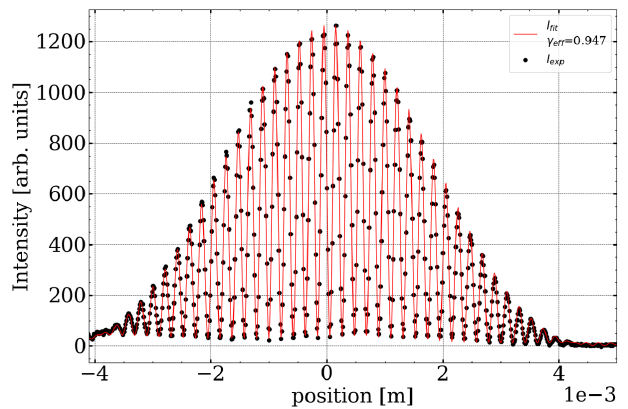
FIG. 3. Example of fitting the 1D experimental interference pattern (black dots) with the analytical function given in Eq. (A10) for the SASE full undulator chain, and for the case of 0.6 mm slit